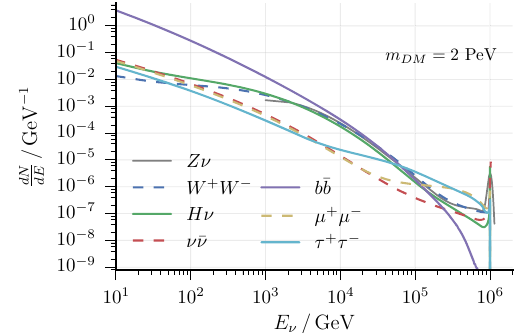
Fig. 2 Neutrinoyieldperdecayasafunctionofneutrinoenergyassum- ing the hard decay channel DM → Z + ν τ : the effects of neutrino mixing and red-shift are